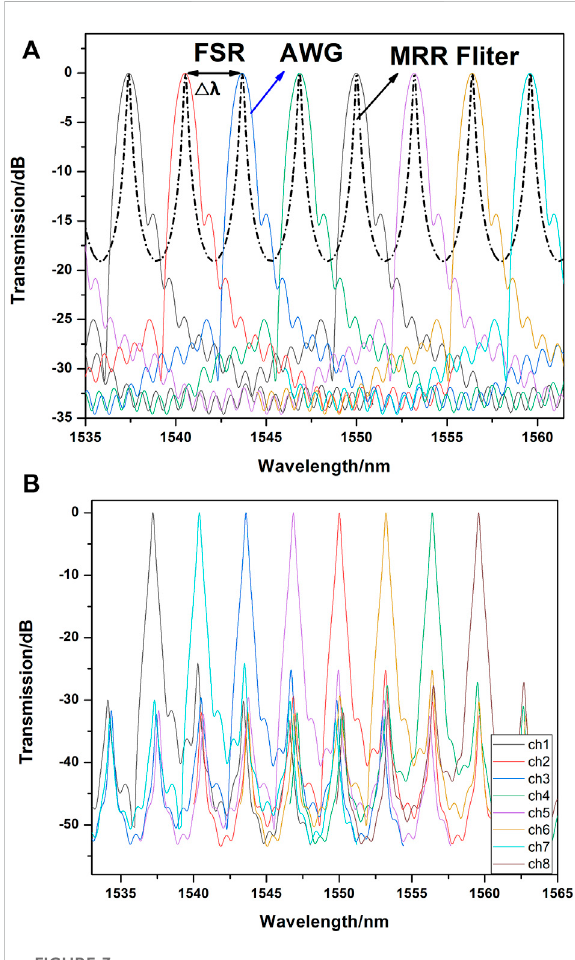
FIGURE 3 (A) Transmission spectrum of 8 output channels